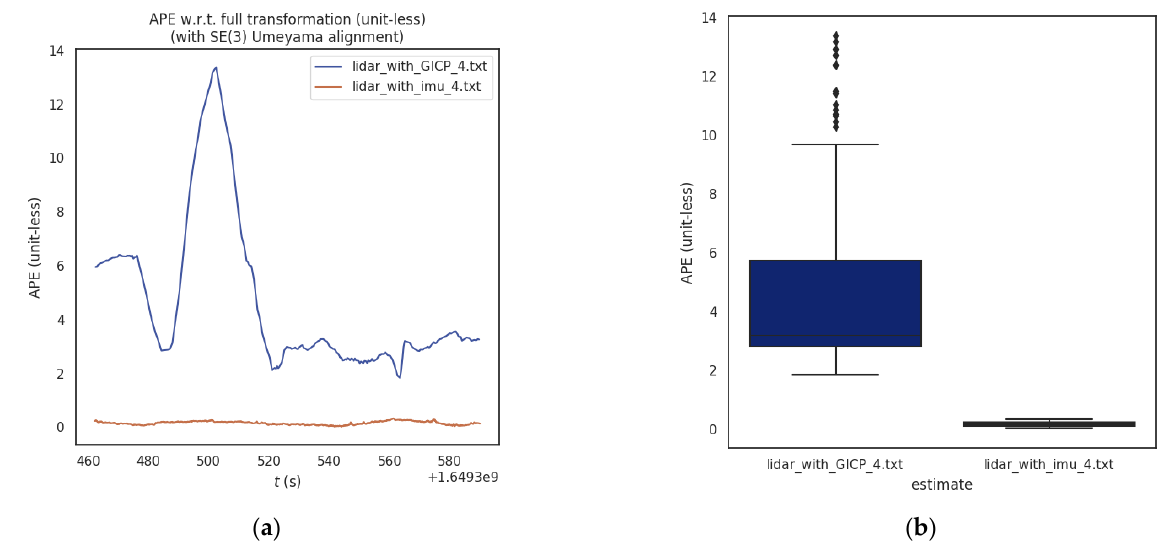
Figure 14. Comparative analysis of absolute position and pose error under SE(3) in Experiment 4. ( a ) Different methods consider the absolute position and pose error of translation and rotation simultaneously; ( b ) Absolute position and pose error box diagram of different methods.